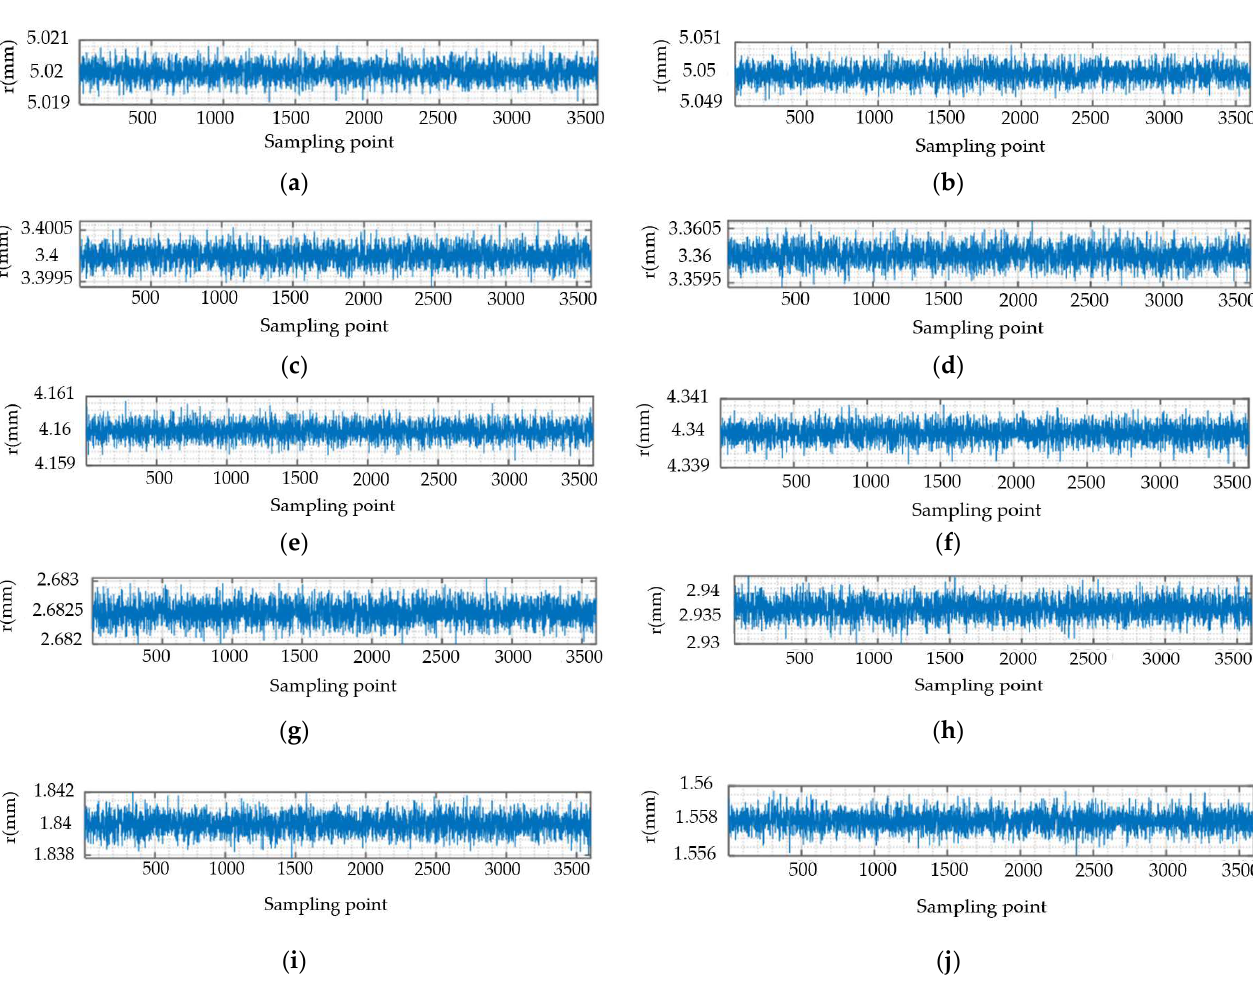
Figure 11. Original signal of ceramic ball surface. ( a ) Sample 1 original signal diagram; ( b ) Sample 2 original signal diagram; ( c ) Sample 3 original signal diagram; ( d ) Sample 4 original signal diagram; ( e ) Sample 5 original signal diagram; ( f ) Sample 6 original signal diagram; ( g ) Sample 7 original signal diagram; ( h ) Sample 8 original signal diagram; ( i ) Sample 9 original signal diagram; ( j ) Sample 10 original signal diagram.